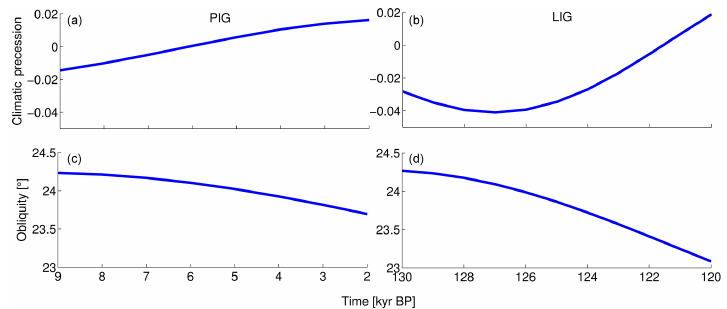
Figure 1. Orbital parameters in the transient experiments for the PIG (a, c) and the LIG (b, d) (Berger,